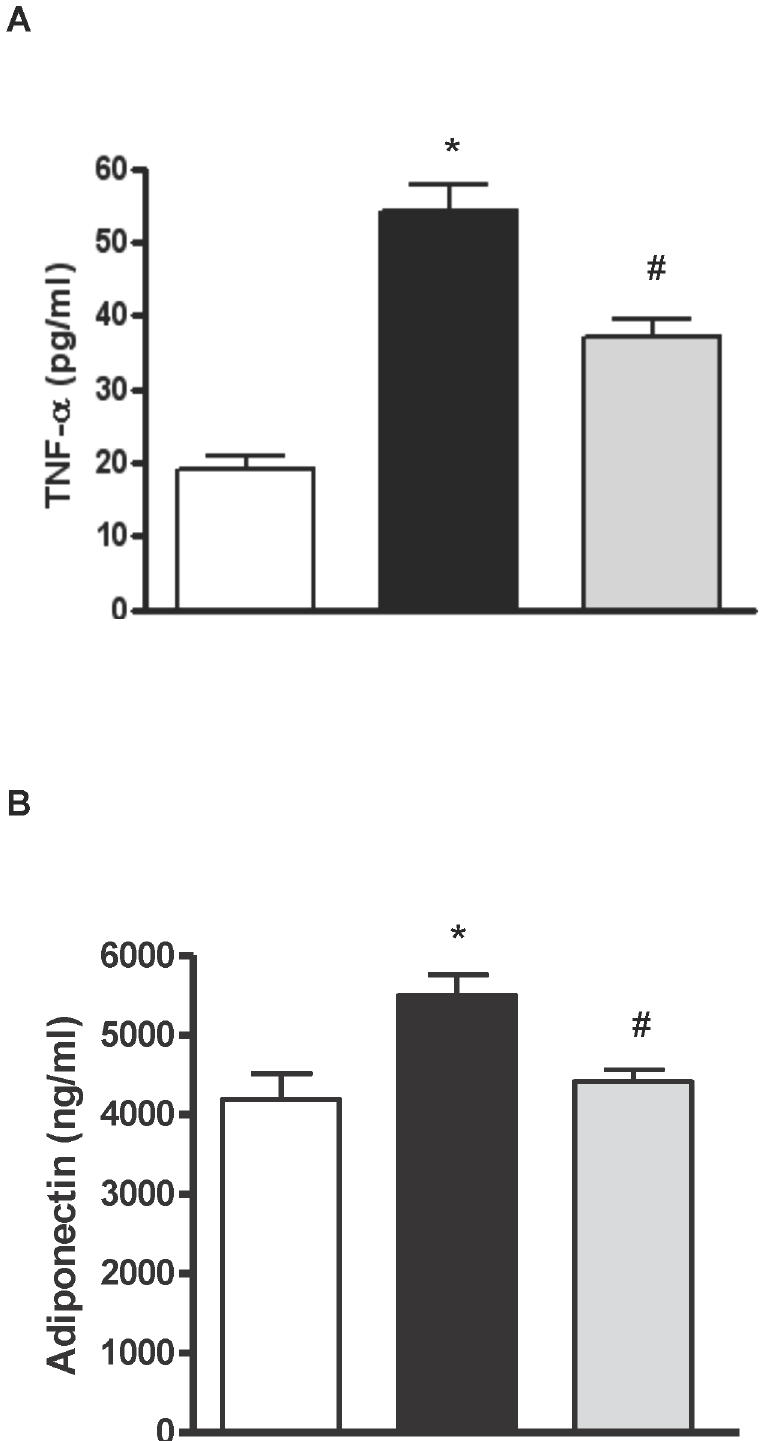
Fig 5. TNF- α and adiponectin. Histograms of A) tumor necrosis factor alpha (TNF- α ) (pg/ml) and B) adiponectin (ng/ml) in plasma of lean Zucker rats (white), obese Zucker rats that received water (black) and obese Zucker rats that received 750 mg/kg/day of pepsin egg white hydrolysate (light grey) for 12 weeks. Values are means ± SEM (n = 10). * P < 0.05 obese vs lean rats, #P < 0.05 obese rats treated with pepsin egg white hydrolysate vs control obese rats.